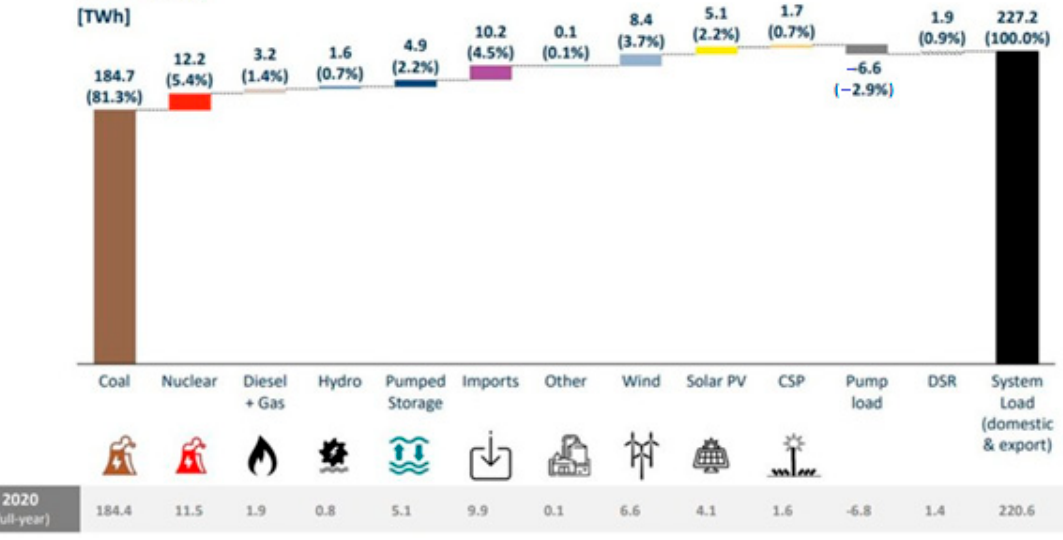
Figure 2. Installed generation capacity in South Africa [1].